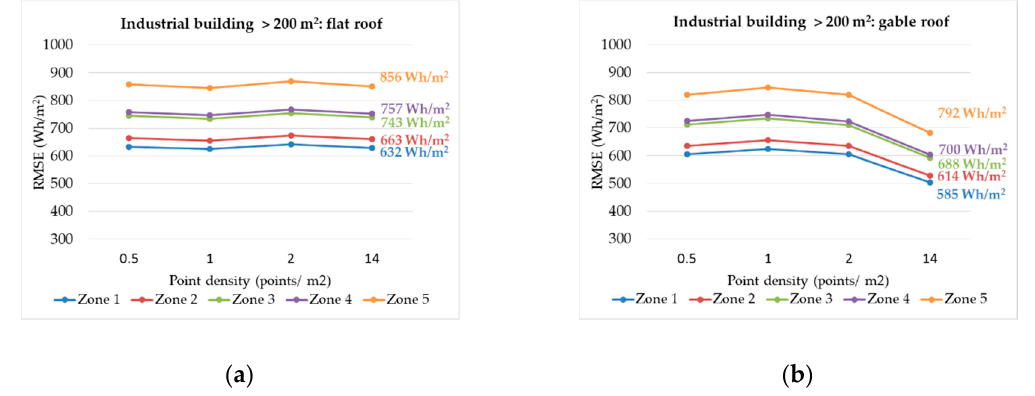
Figure 15. Average daily PV energy production per square meter loss (Wh/m 2 ) for industrial buildings with an area bigger than 200 m 2 : ( a ) flat roof, ( b ) gable roof.